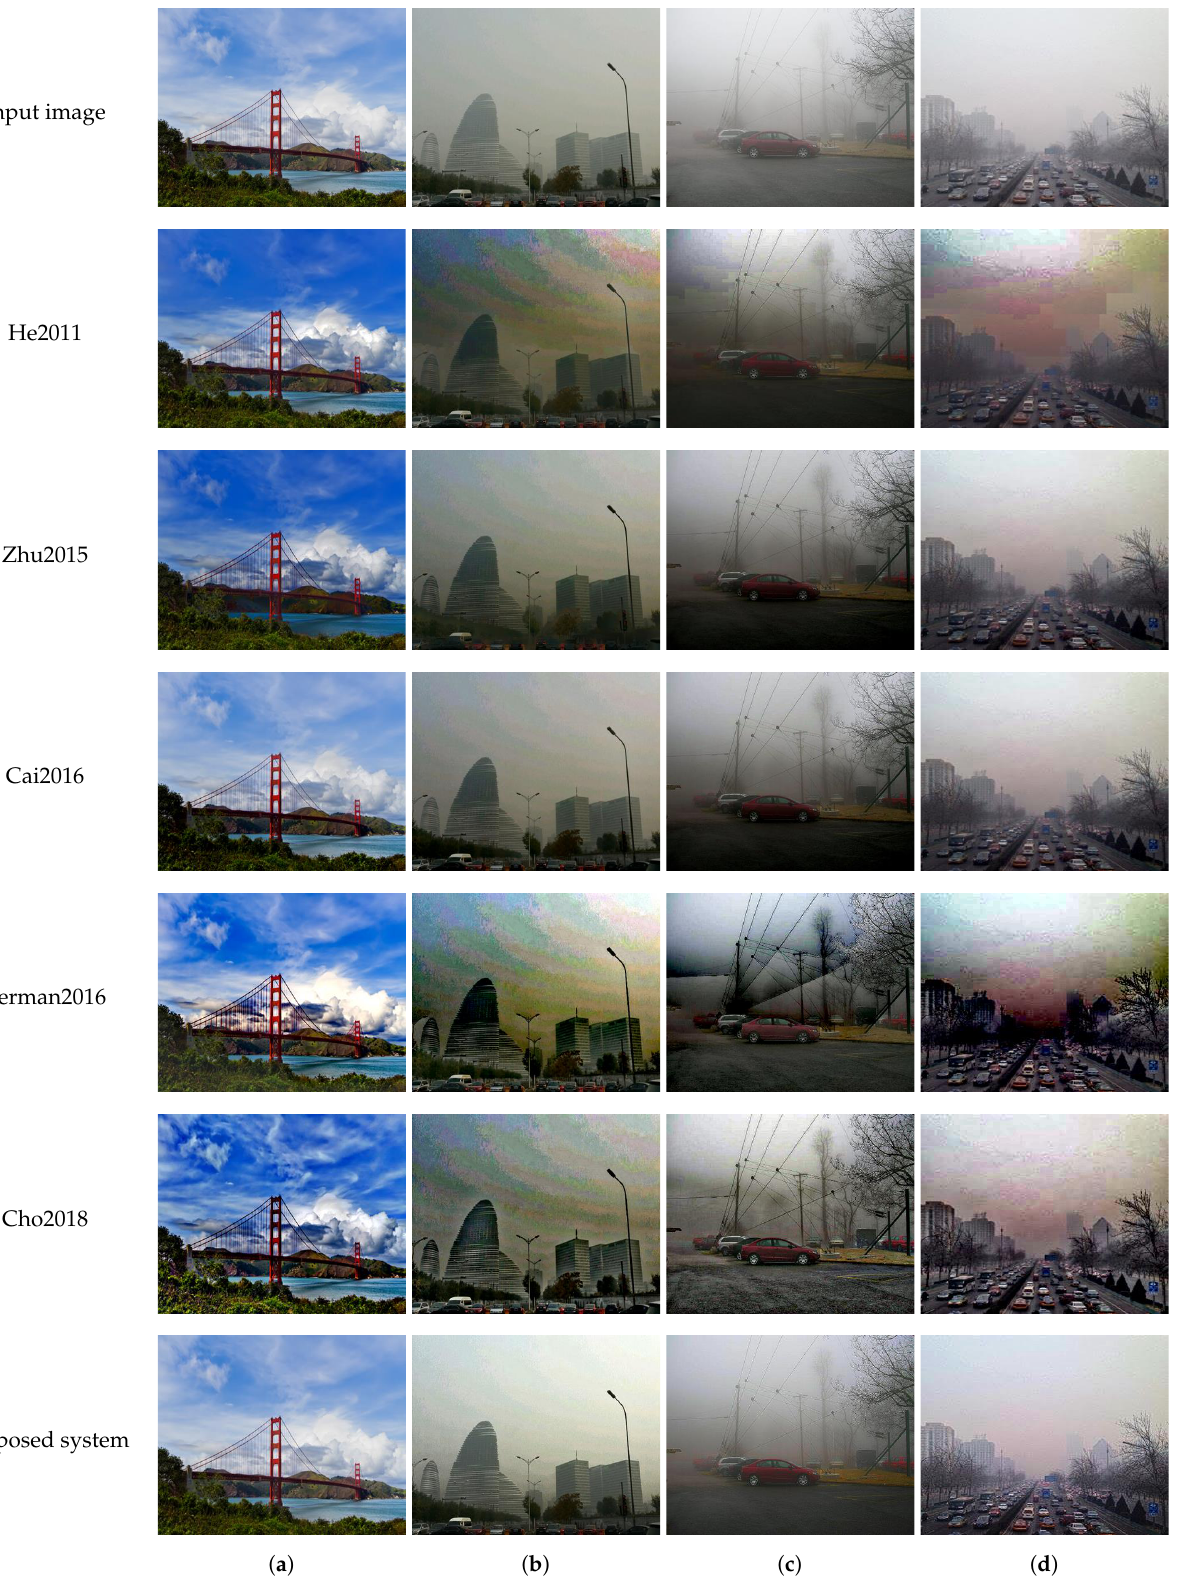
Figure 7. Qualitative evaluation of different image dehazing methods on outdoor images. ( a – d ) corre- spond to four haze conditions: haze-free, thin, moderate, and dense. The ρ I values of input images are 0.7853, 0.8986, 0.9216, and 0.9388, respectively. He2011, Zhu2015, Cai2016, Berman2016, and Cho2018 denote five benchmark methods of He et al. [9], Zhu et al. [11], Cai et al. [13], Berman et al. [12], and Cho et al.